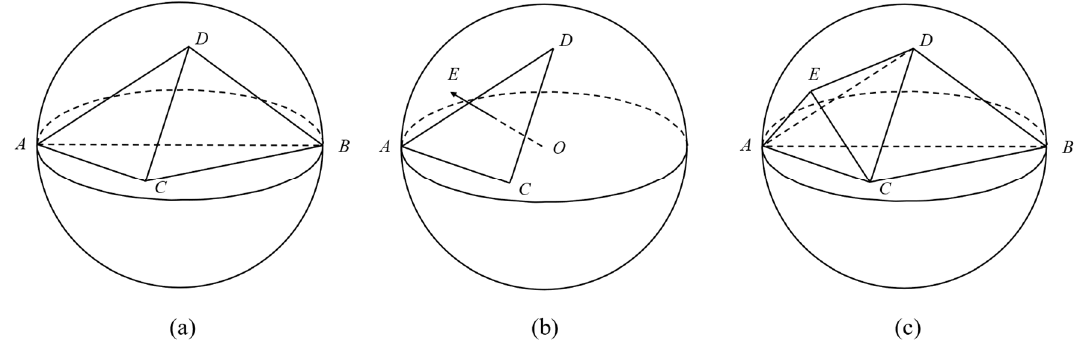
Figure 3. Generation process of angular grains: ( a ) generate the base tetrahedron; ( b ) generate a new vertex on the triangle with the largest surface area; ( c ) generate a new tetrahedron based on the newly generated vertex